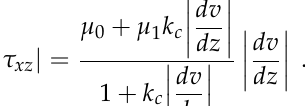
Table 1. Orders of rheological constants in the Hersche–Bulkley model for different natural flows. ρ , kg/m 3 τ y , Pa K , Pa · s n n Comment 200 0 0.2 1 dense dry snow avalanche [108] 400 ± 50 740 ± 100 0.033 2 dense snow [109] water-debris flow mixture 2000 400 100 0.33 of the concentration 68.4% [110,111] mineral particles suspension 1300 0.03 0.8 of the concentration 3–5% [112] 1 silicic lava